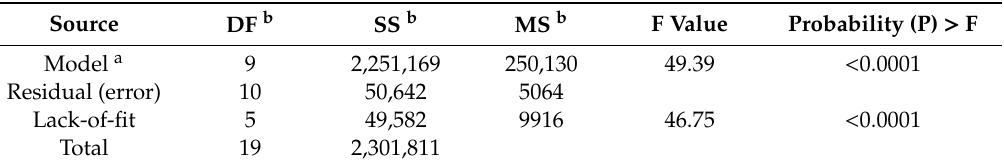
Table 5. ANOVA for the empirical model.